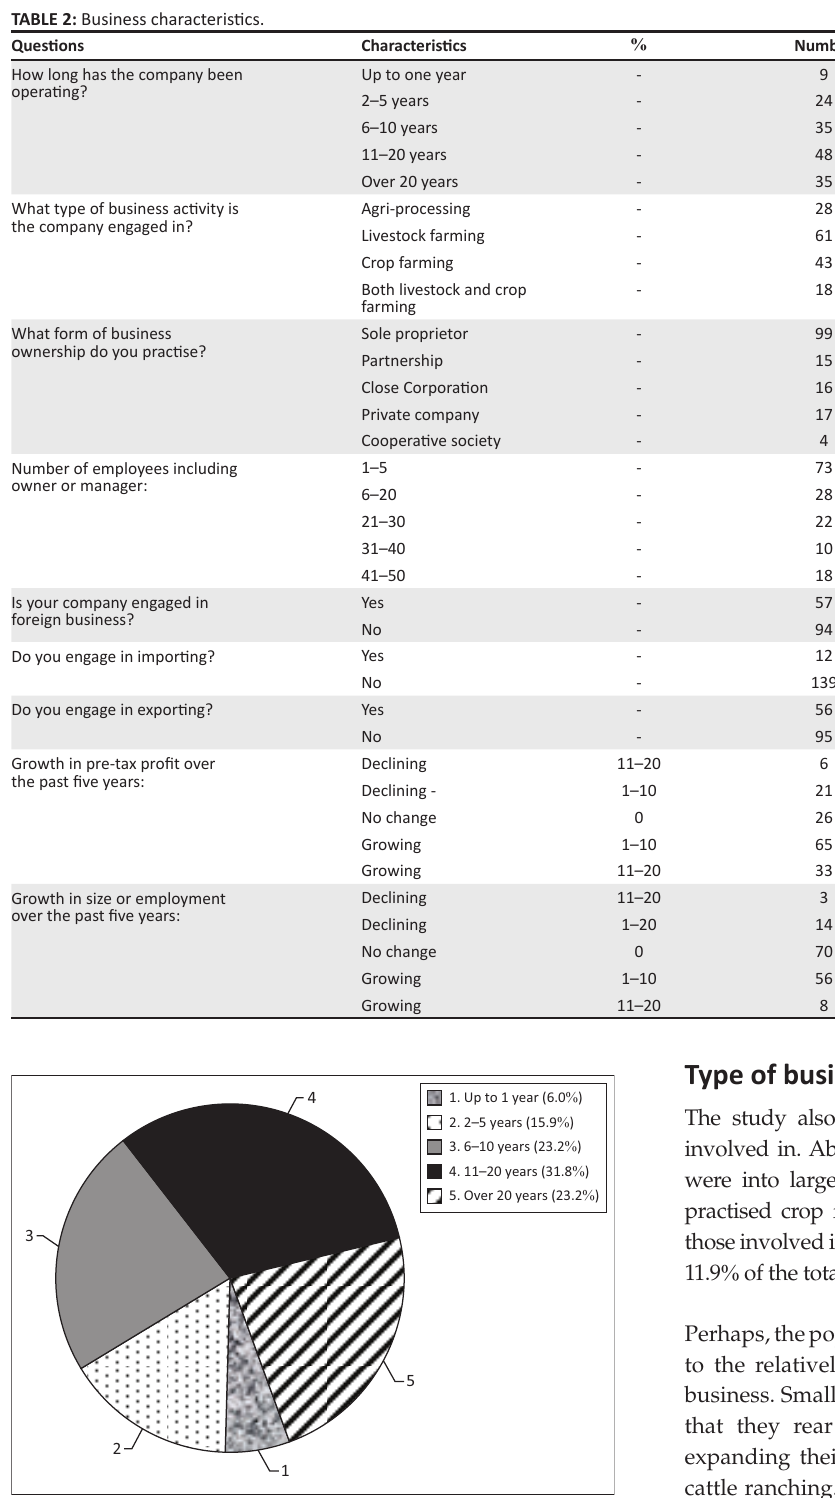
FIGURE 5: Number of years that the business has been in operation.